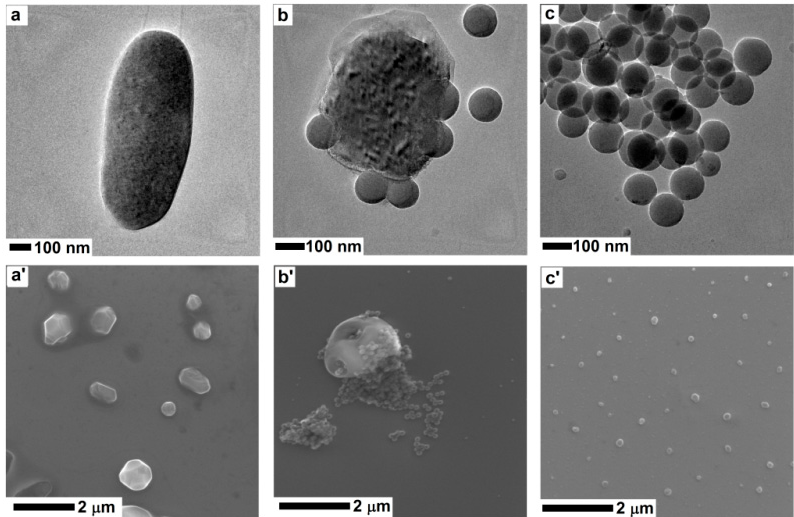
Figure 5. TEM and SEM (scanning electron microscope) images of Oenococcus oeni (DSM7008) ( a , a’ ), Oenococcus oeni (DSM7008) stirred with nanospheres ( b , b’ ), and pristine silica nanospheres ( c , c’ ), all from PBS solution. Foods 2020 , 9 , x FOR PEER REVIEW